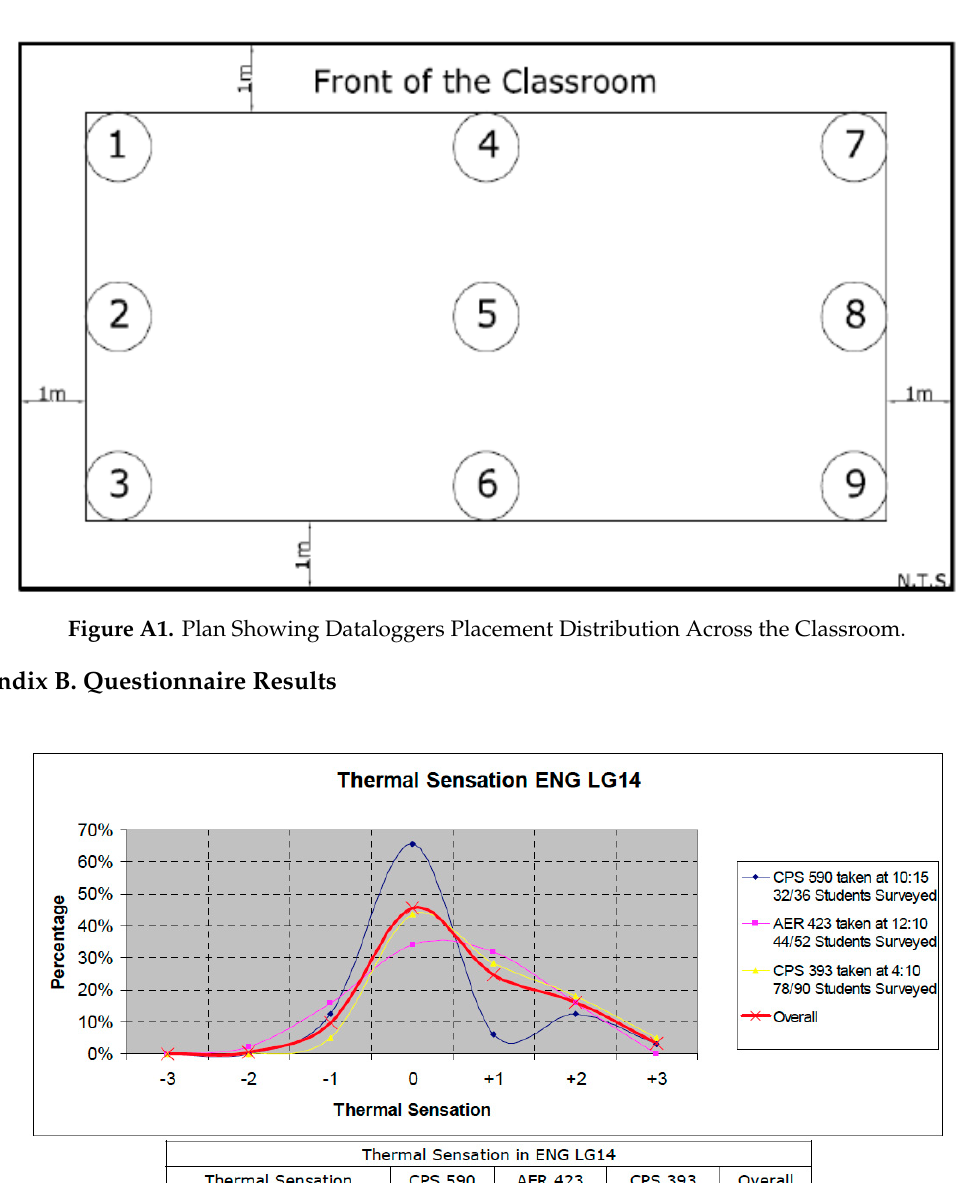
Figure A3. Thermal Satisfaction Survey Results.